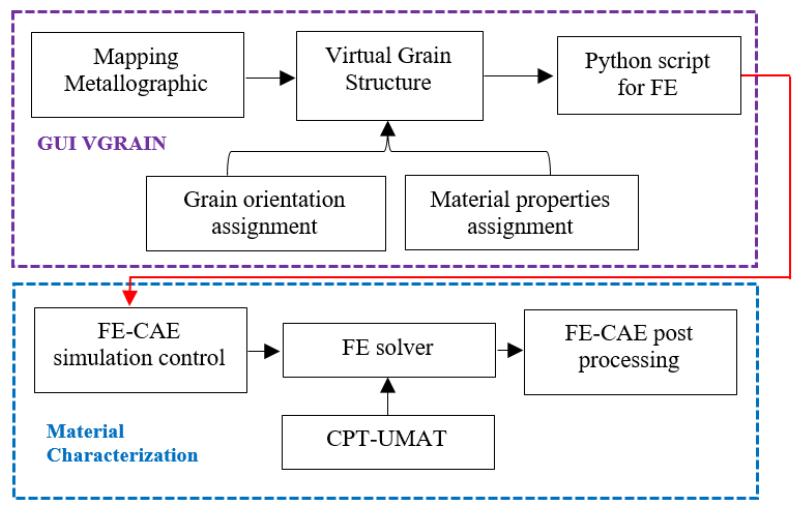
Figure 6. Integration procedure of the VGRAIN system for micromechanics analyses with CPT.